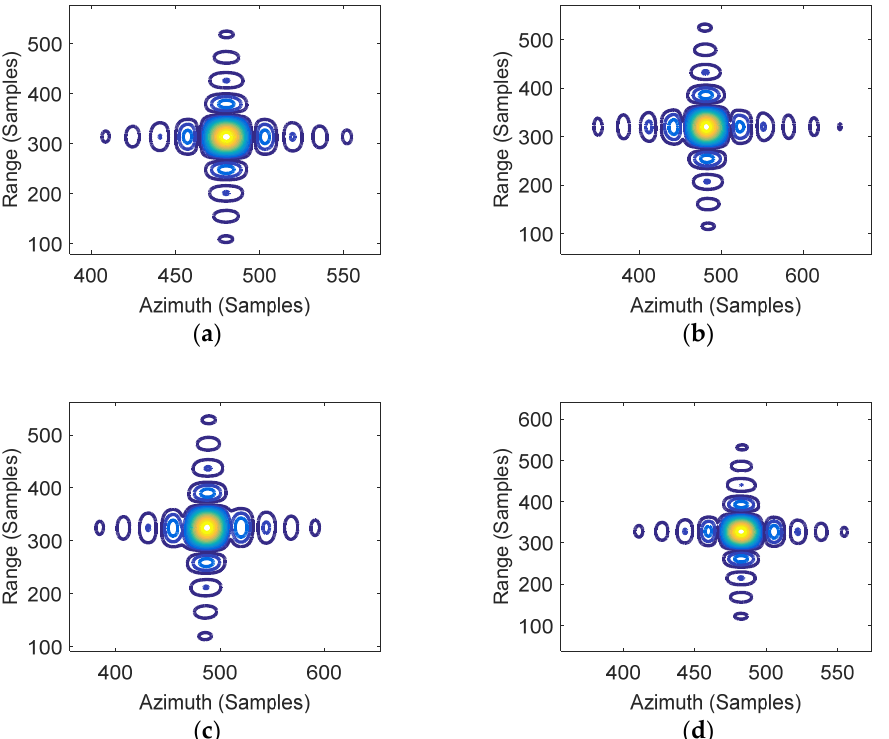
Figure 8. 2-D IRF of targets by CPFA. ( a ) PT0; ( b ) PT1; ( c ) PT2; ( d ) PT3.